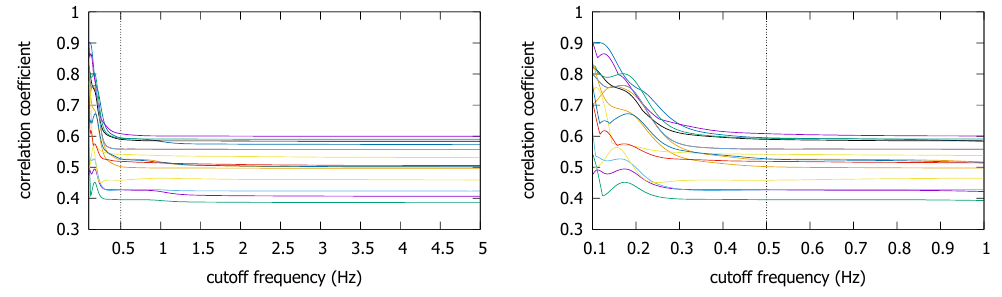
Figure 15. ρ max for non-coexistent trace pairs from the three buildings in the Korea University